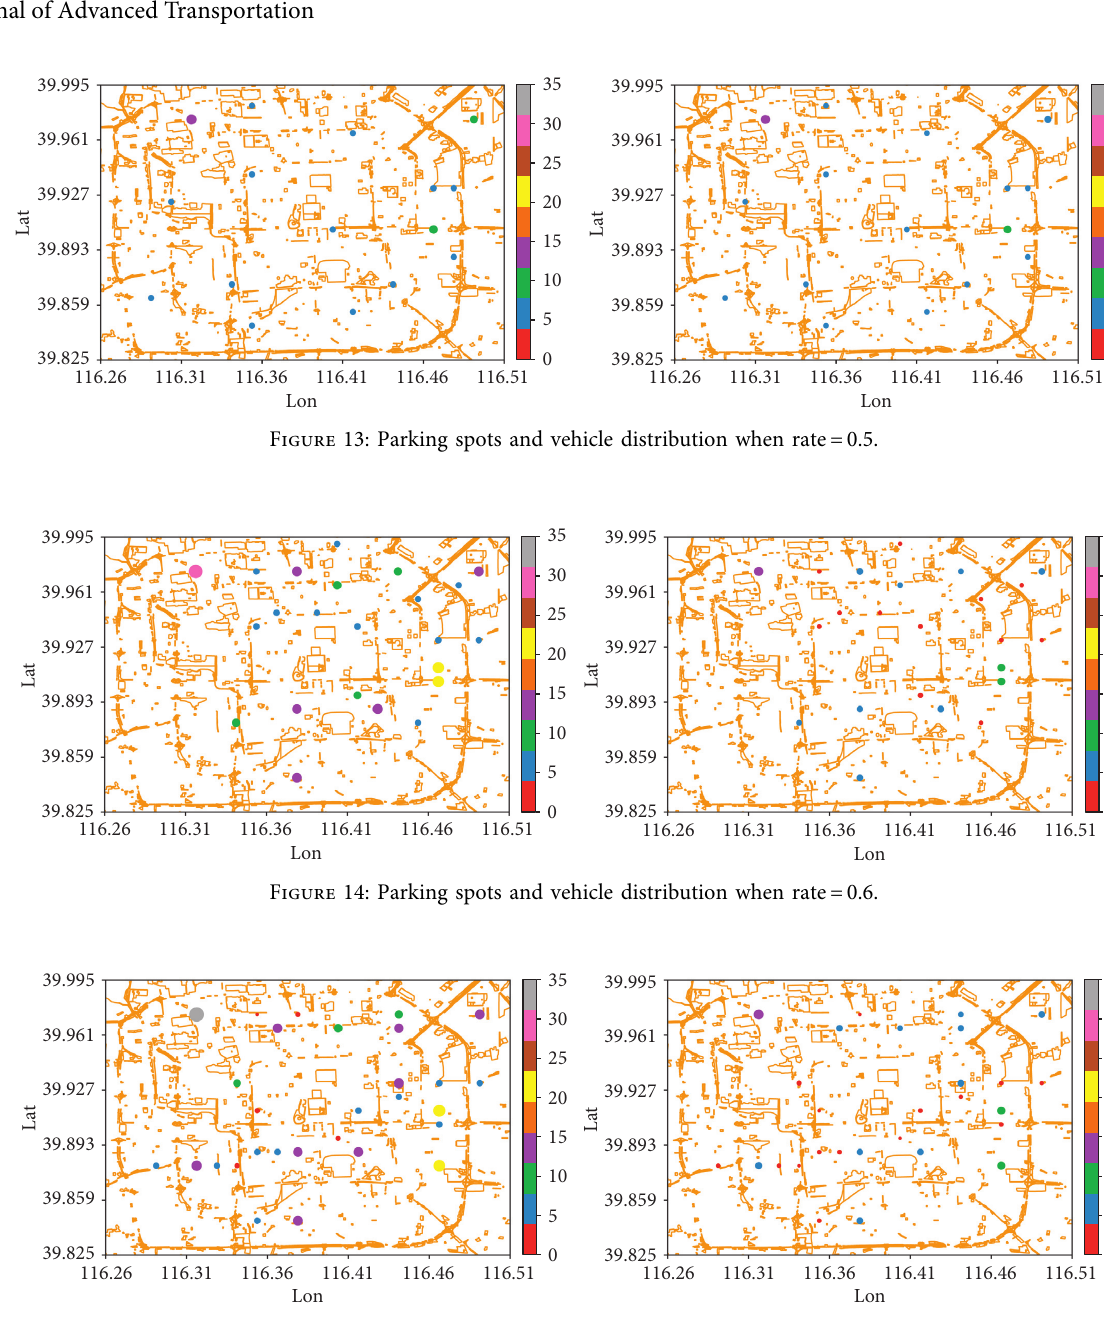
Figure 15: Parking spots and vehicle distribution when rate � 0.7. Table 1: Results of the